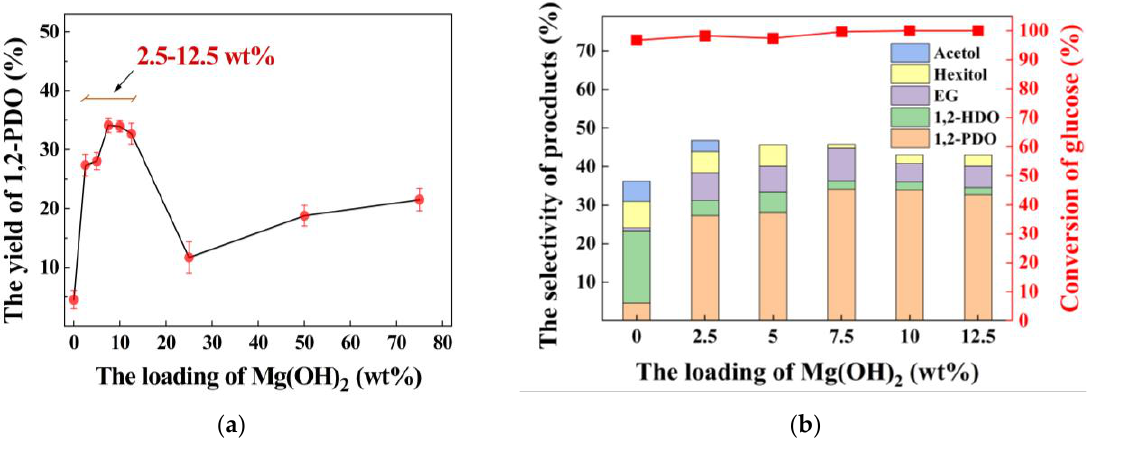
Figure 3. The effect of Mg(OH) 2 loading on hydrogenolysis of glucose into 1,2-PDO. ( a ) effect of Mg(OH) 2 loading(0 – 80 wt%) on 1,2-PDO production; ( b ) effect of Mg(OH) 2 loading on 1,2-PDO pro- duction (0 – 12.5 wt%) and selectivity of production. Reaction condition: catalyst (200 mg), glucose (11.25 mg/mL, 10 mL) and H2 (initial 6 MPa) at 200 °C for 3 h.